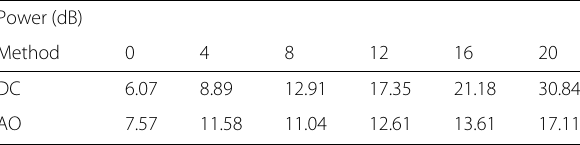
Table 1 Averaged running times (in seconds) Power (dB)